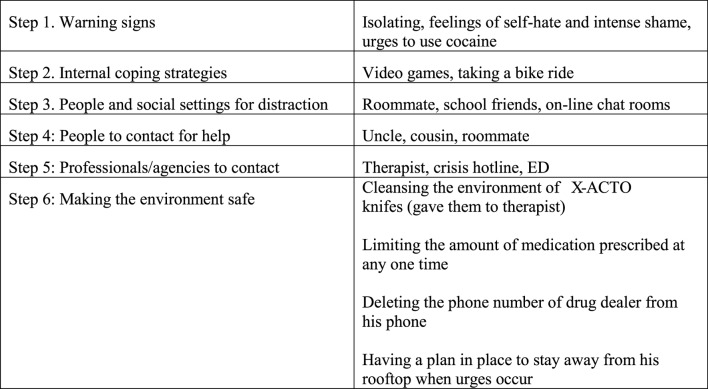
Paul’s Safety Plan.